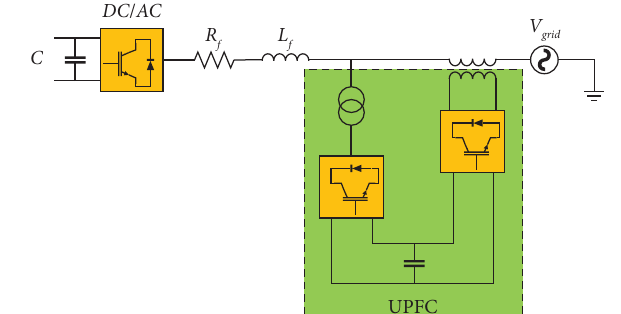
Figure 11: Te connection of UPQC to the PCC.